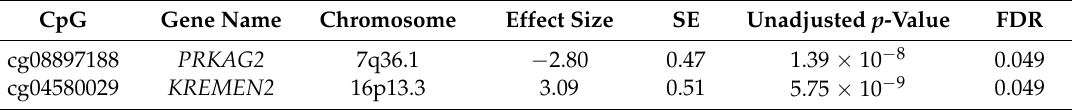
Table 1. Association of methylation values with TG level.